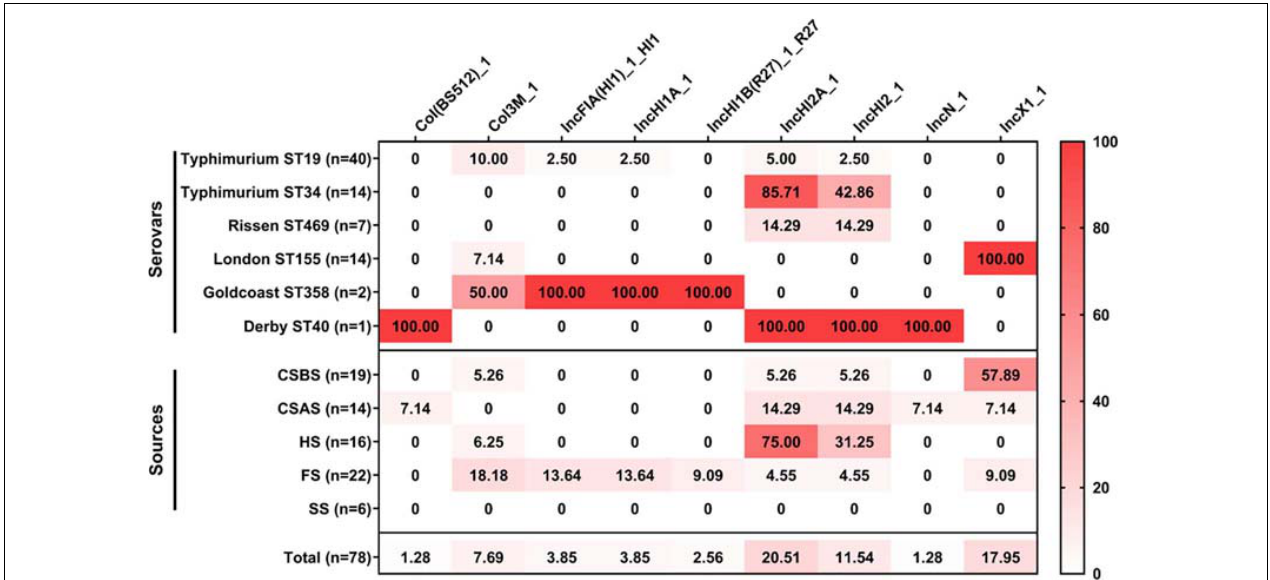
FIGURE 5 | Heatmap of plasmid replicon distribution in the studied Salmonella isolates ( n = 78). The numbers in cells correspond to the prevalence (%) of plasmid replicons in Salmonella isolates according to serovar distribution and sampling sources.